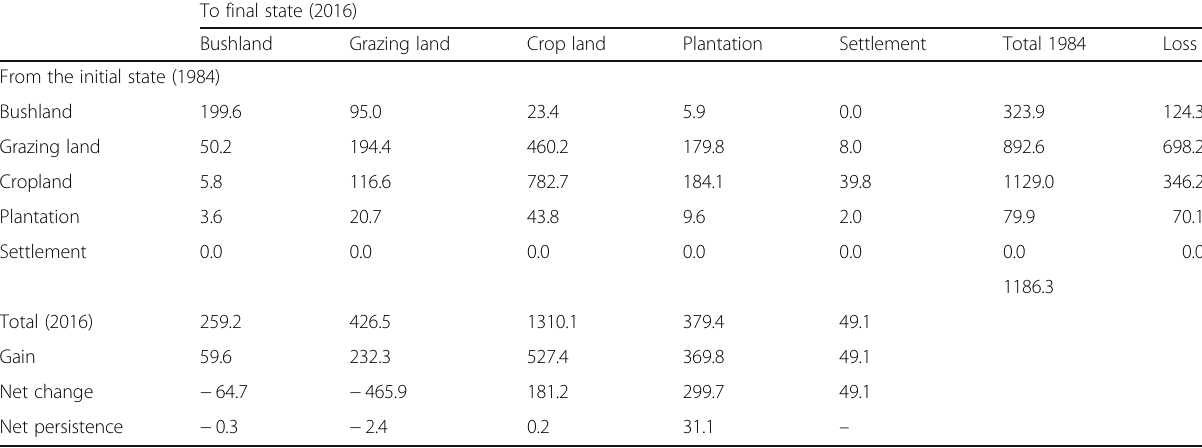
Table 7 LULC transition matrix showing major changes in the landscape 1984 – 2016 (%) To final state